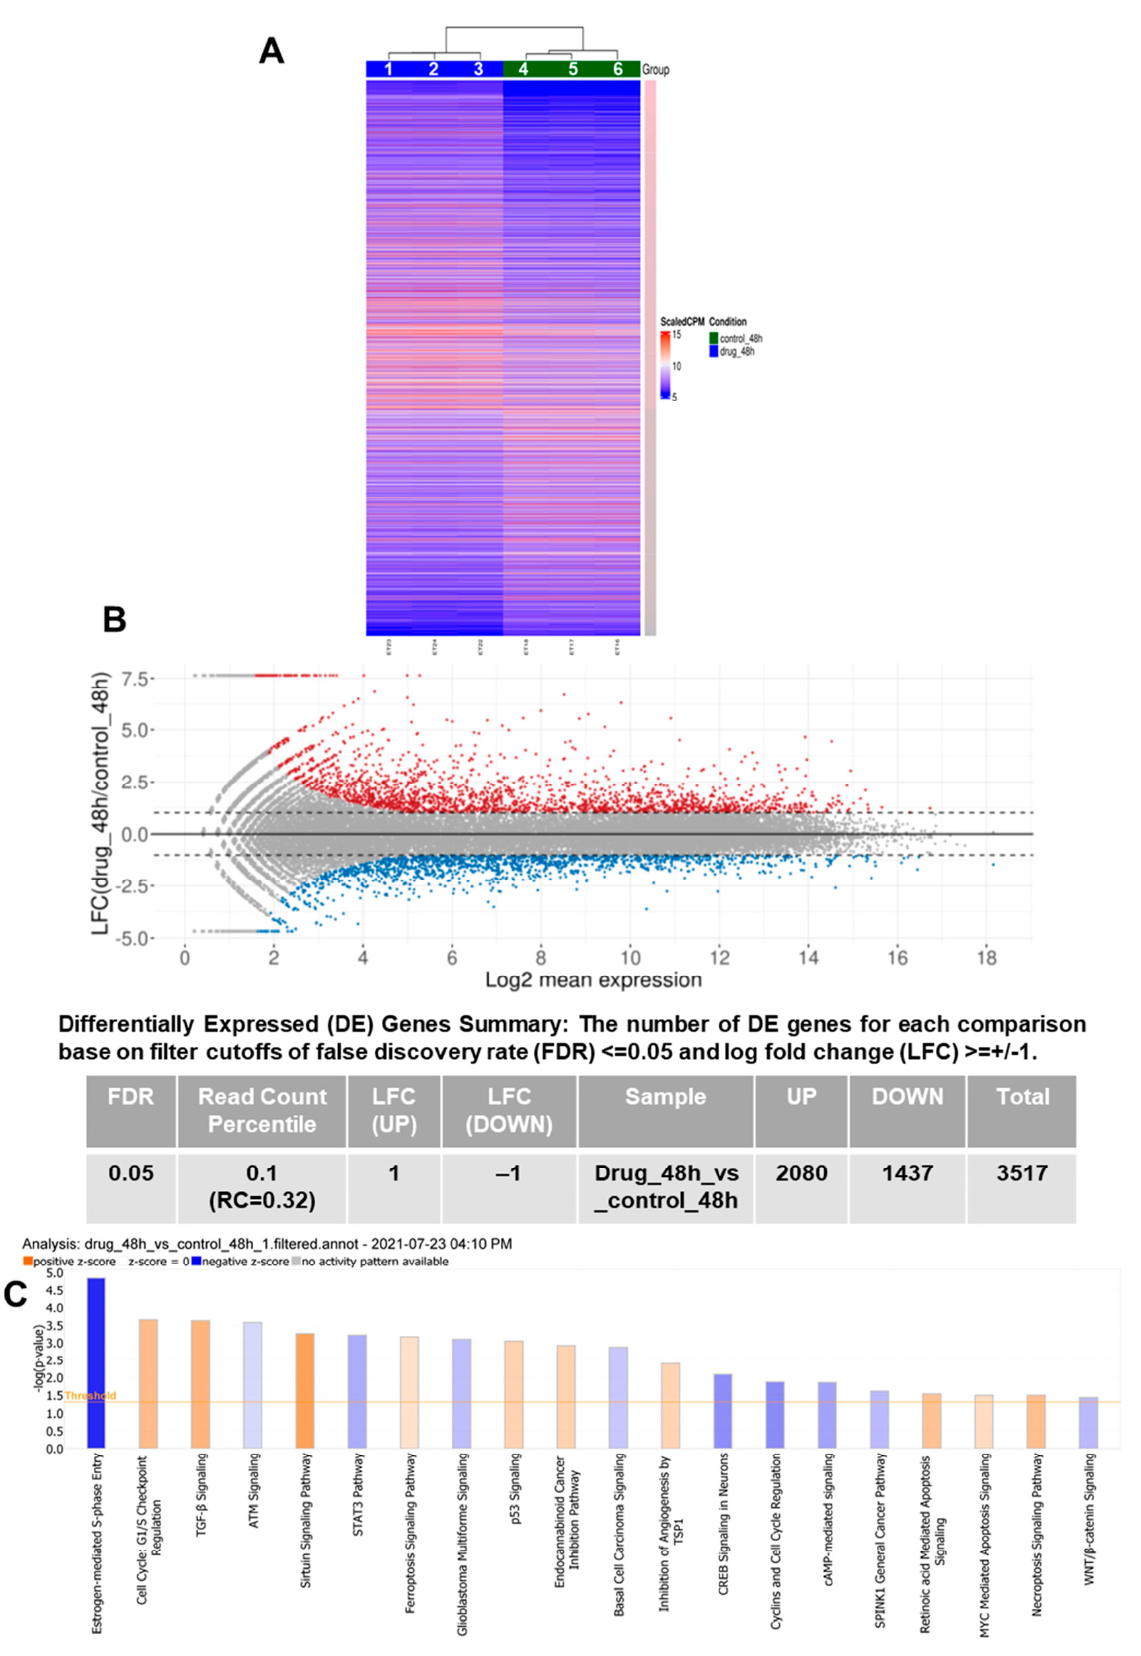
Figure 1. RNA-seq and transcriptome analyses demonstrate modulation of several pathways in favor of PCa inhibition upon treating CWR22Rv1 cells with VNPP433-3 β . ( A ) Heatmap of